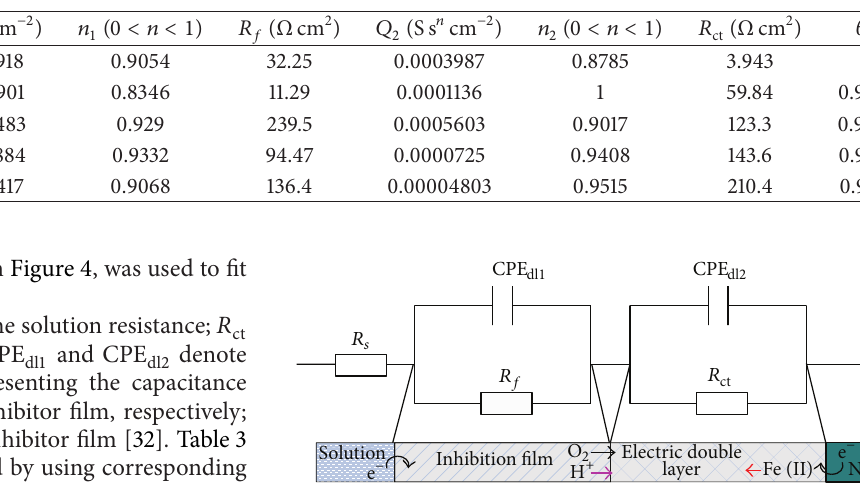
Figure 4: The equivalent circuit used to model the electrochemical impedance spectroscopy data at open circuit potential at 25 ± 1 ∘